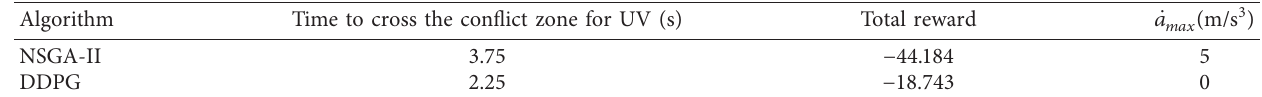
Table 1: Comparison data of two algorithms.